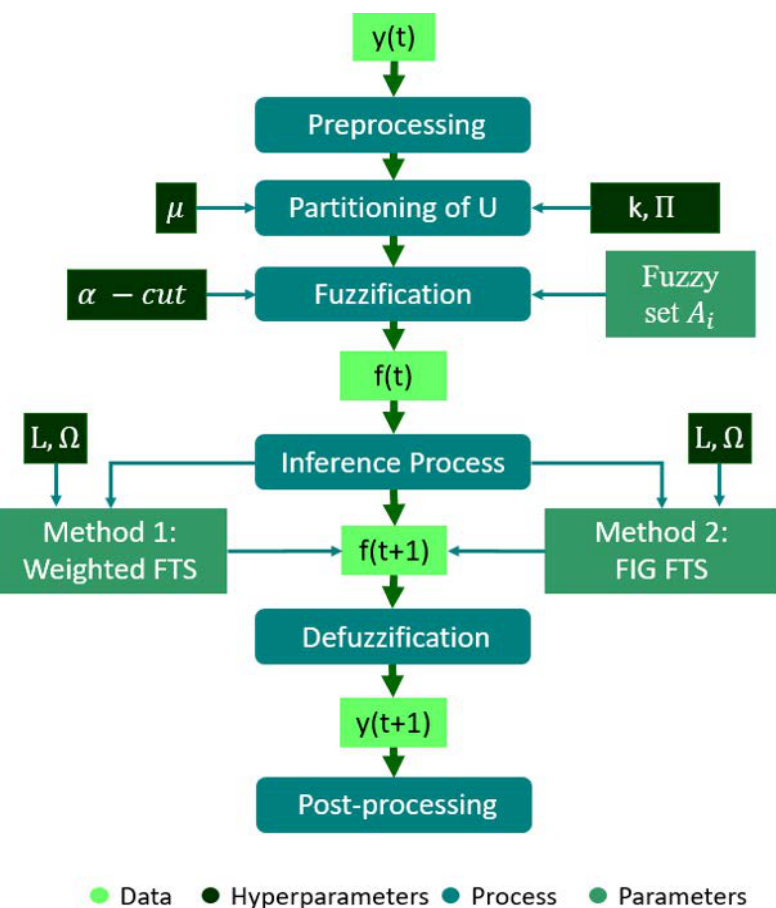
Figure 1. Algorithm of the forecasting process with the FTS (adapted from [22]).